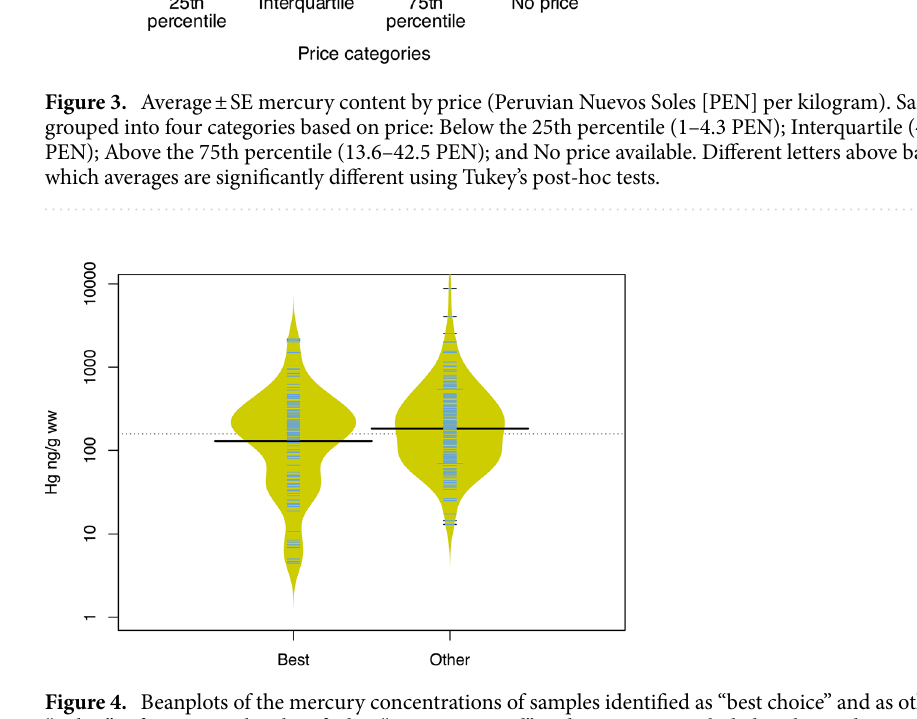
Figure 4. Beanplots of the mercury concentrations of samples identified as “best choice” and as other species. “Other” refers to samples classified as “species to avoid” and species not included in the guides. Each “bean” shows the distribution of mercury concentrations in Hg ng/g ww. The y-axis is log transformed. The black lines in each bean indicate the average mercury concentration for each group. Each blue horizontal line represents a sample. The dotted line indicates the overall average mercury concentration for all samples (331 Hg ng/g ww, n =